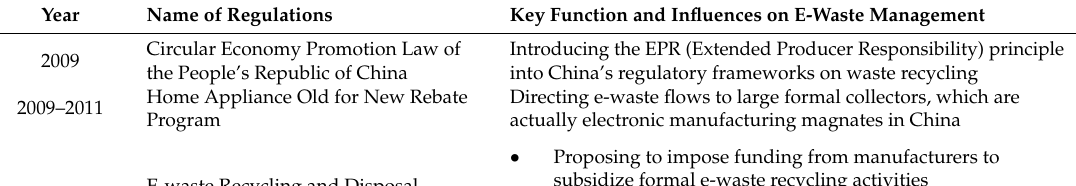
Table 5. China’s key legislation on e-waste in the recent decade. Key Function and Influences on E-Waste